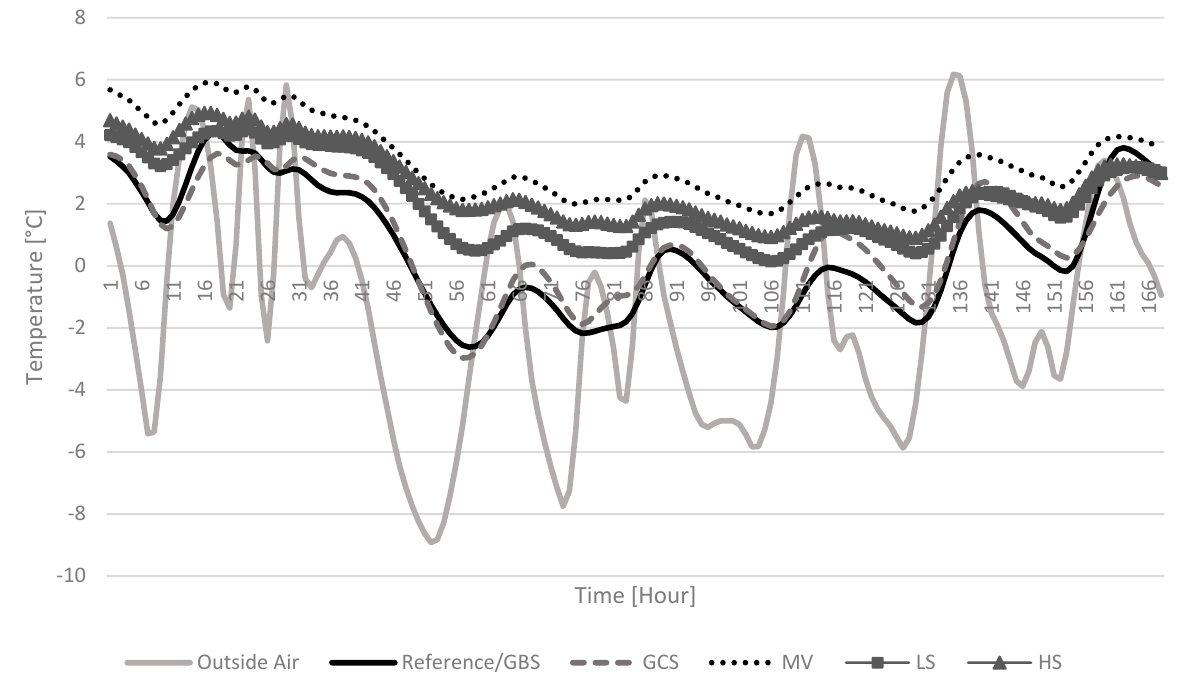
Figure 7. Winter. Comparison between the operative temperatures obtained for each category and outside air.